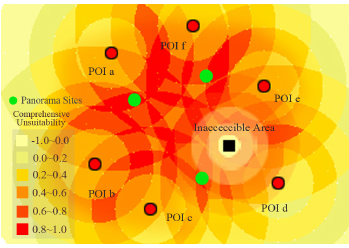
Figure 13. Final result of panorama sites